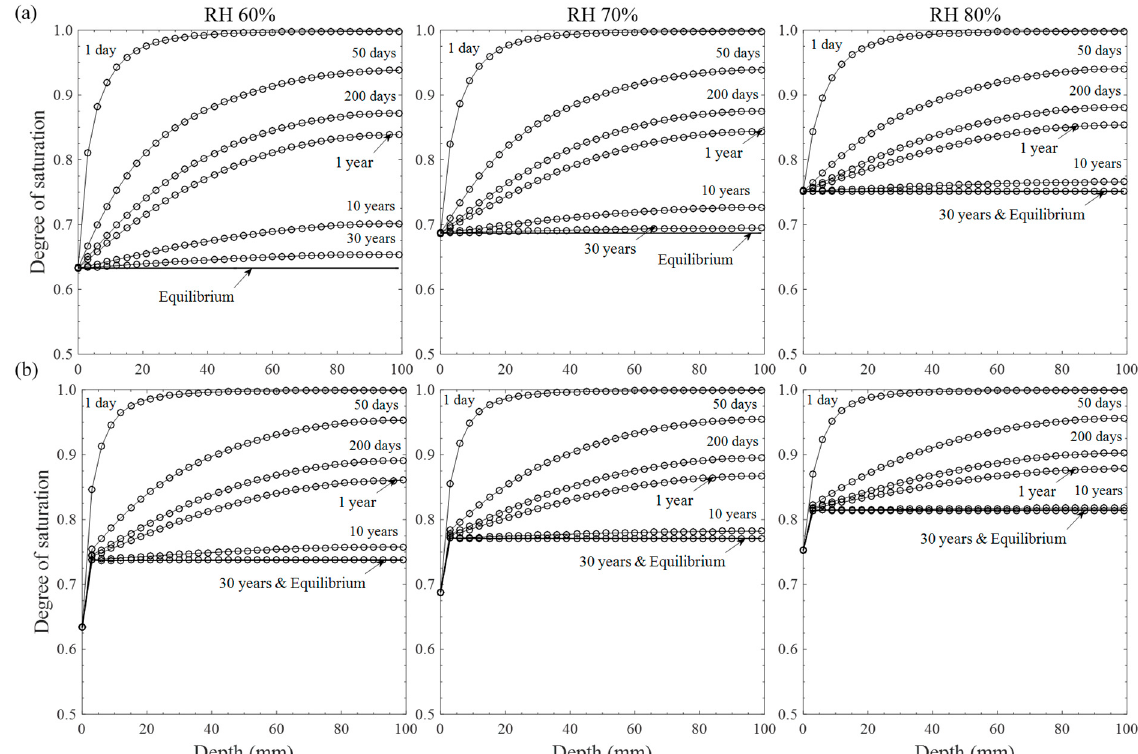
Figure 3. Moisture distributions with relative humidity levels under ( a ) constant drying and ( b ) 12 h for each wet/dry cycle.